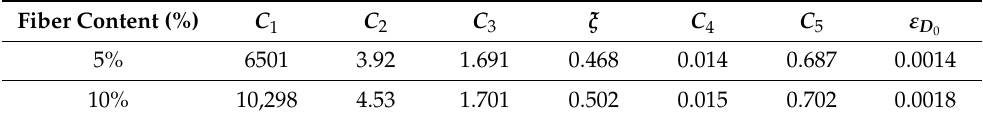
Table 2. Homogenized material properties for wollastonite fibers in